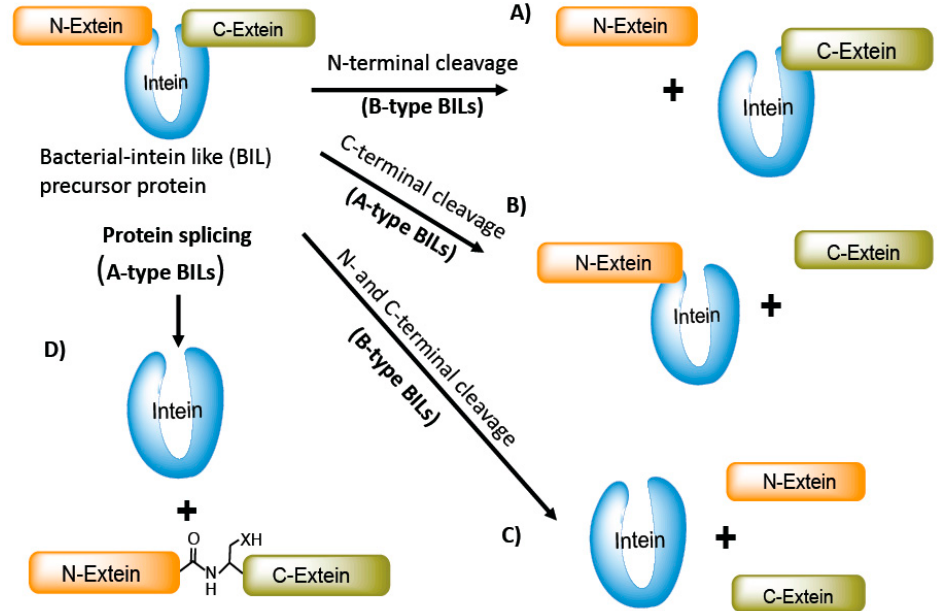
Figure 2. Bacterial intein-like (BIL) proteins and their splicing behavior. BILs precursor